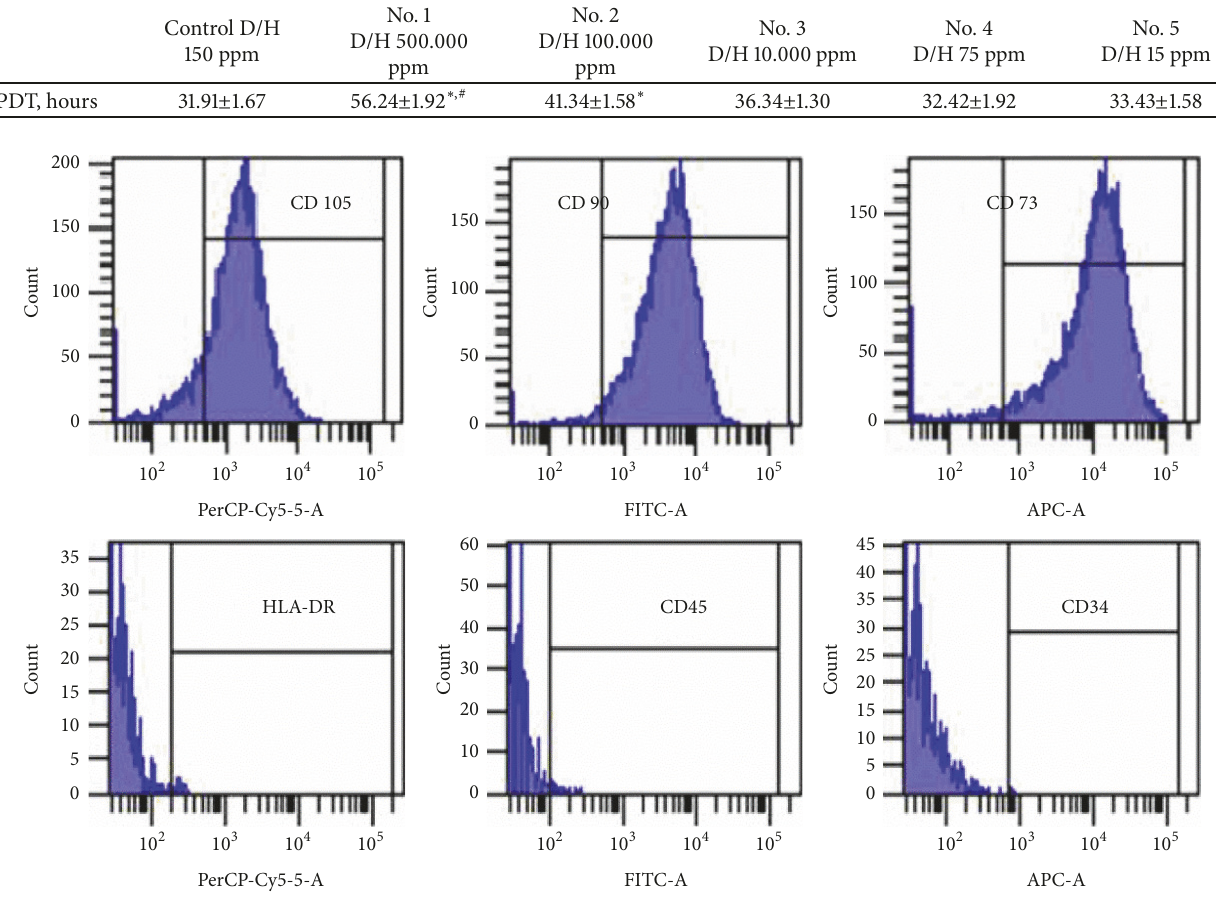
Figure 1: Representative FACS